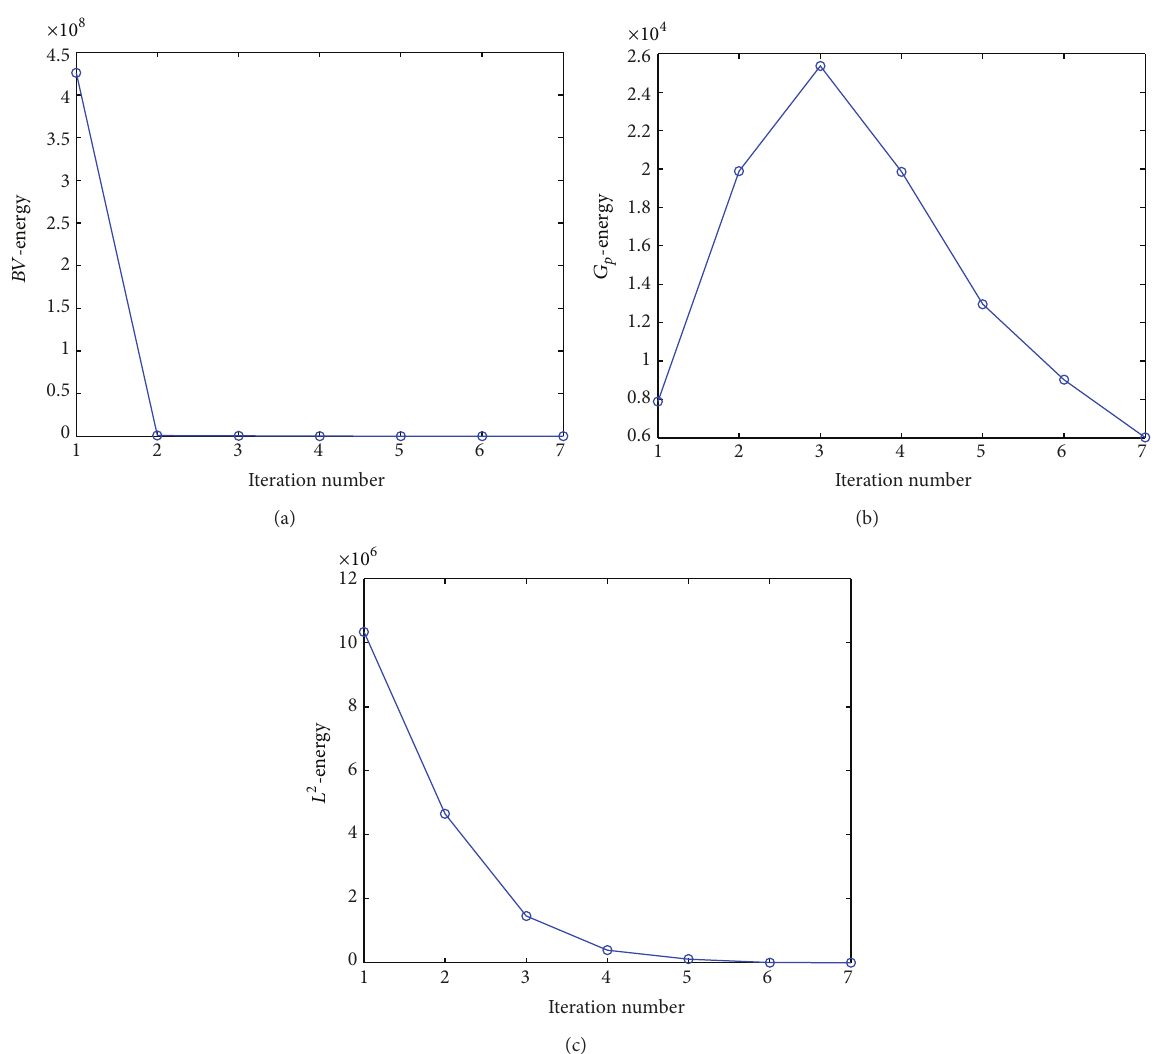
Figure 3: Energy plots of three components. (a) The 𝐵𝑉 -energy of 𝑢 𝑖 . (b) The 𝐺 𝑝 -energy of V 𝑖 . (c) The 𝐿 2 -energy of 𝑟 𝑖 .